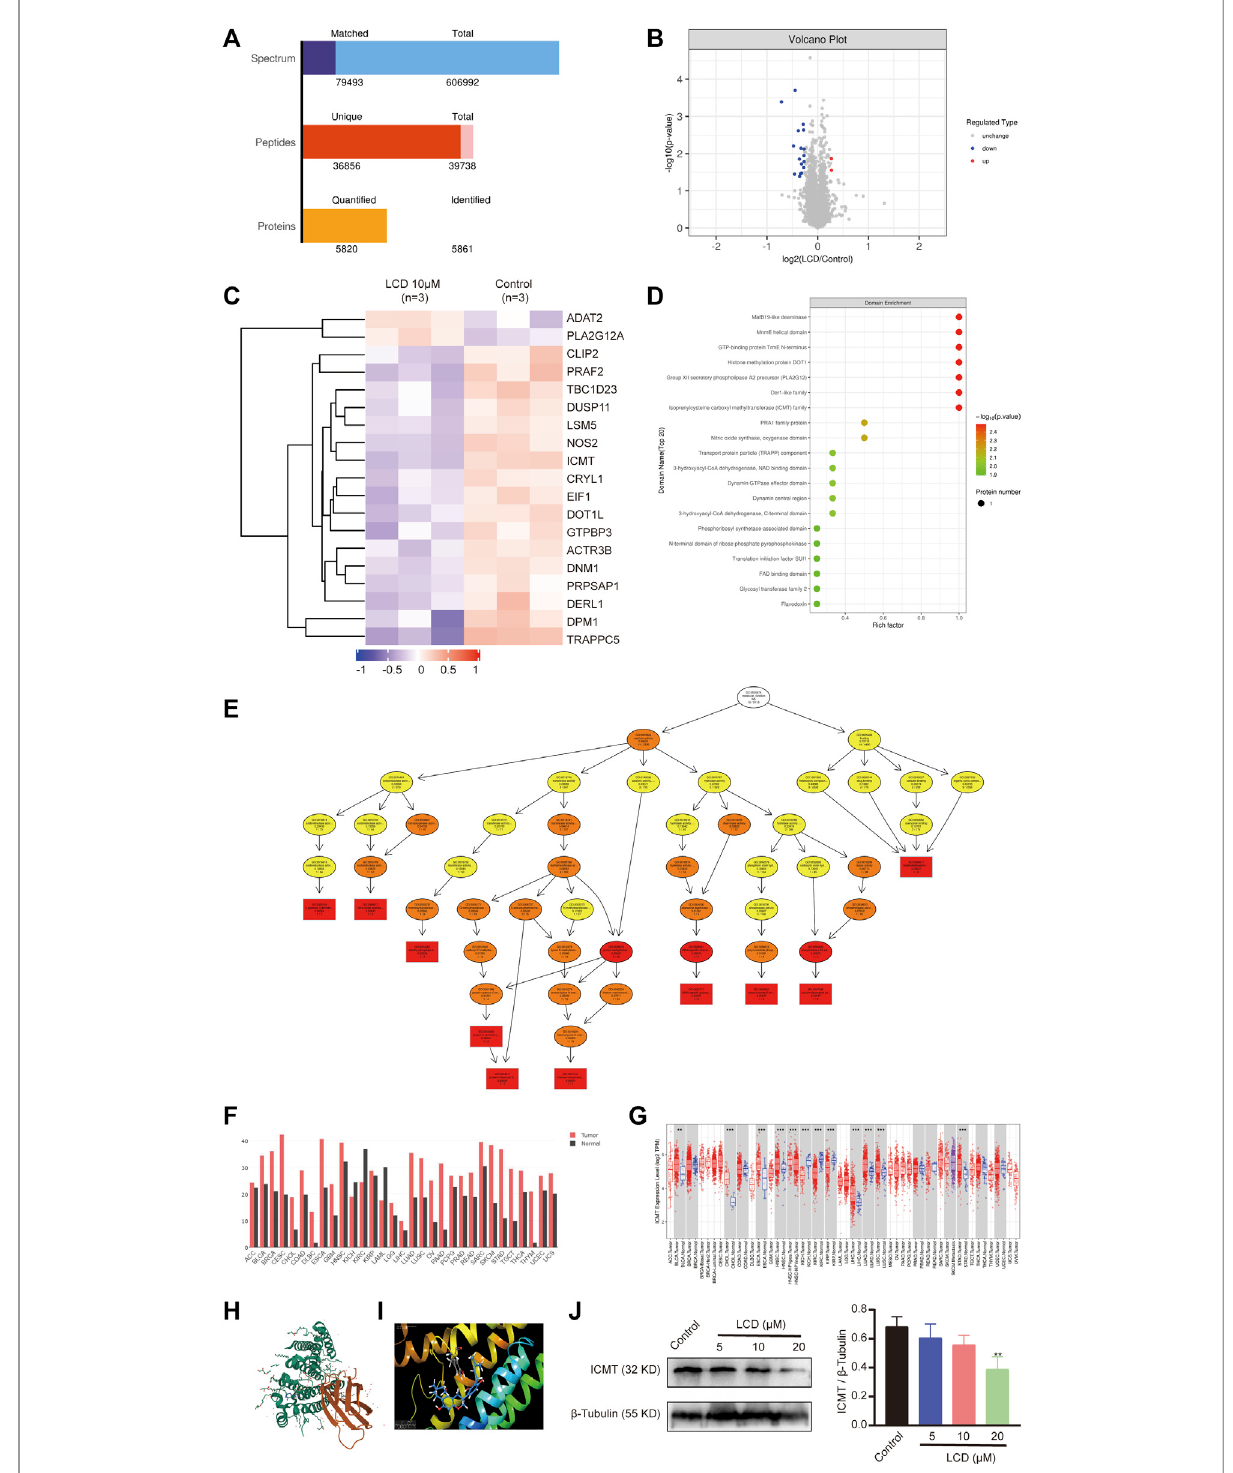
FIGURE 6 Targets of licoricidin inhibiting the growth of gastric cancer cells were identi fi ed by the quantitative proteomics research strategy of TMT labeling. MGC-803 cells were treated with 10 μ M of licoricidin or untreated as a control. After protein extraction, mass spectrometry identi fi cation, and database search, the differential proteins were screened out. Independent experiments were repeated three times. (A) Statistics of the protein identi fi cation results. (B) Volcano plot of differentially expressed proteins. The signi fi cantly downregulated proteins are marked in blue (FC <